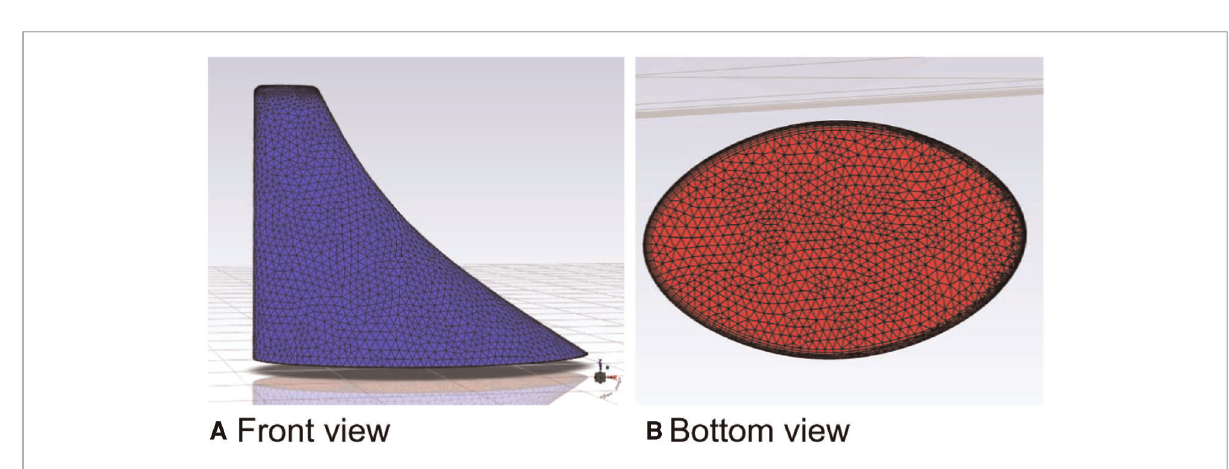
FIGURE 6 Curved model of the spindle